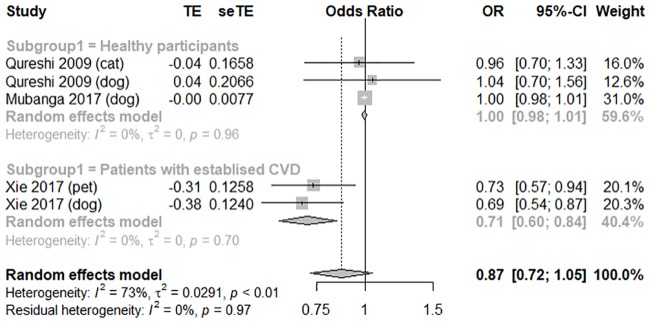
A forest plot showing the risk of cardiovascular disease, comparing pet owners and non-pet owners, with a subgroup analysis by participants health status.CI, confidence interval; OR, odds ratio; SE, standard error; TE, treatment effect.